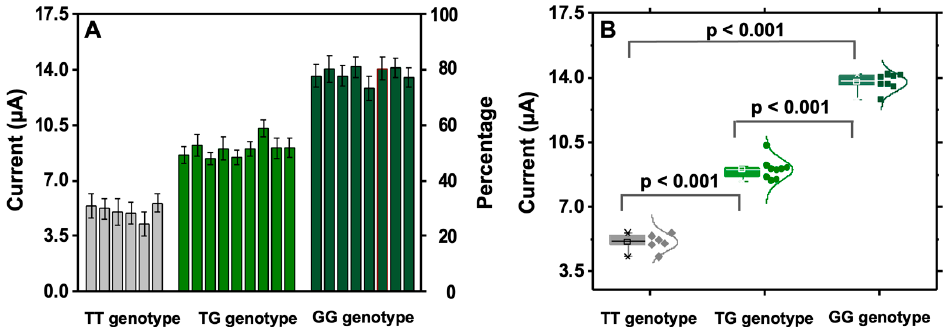
Figure 3. Amperometric response from the analysis ( A ) and ( B ) box plot showing the currents and their mean values recorded for real samples of control subjects and patients (diamonds, circles, and squares) having heterozygous or homozygous genotypes in IL6. One-sample t -test statistical analysis p -value is <0.001.